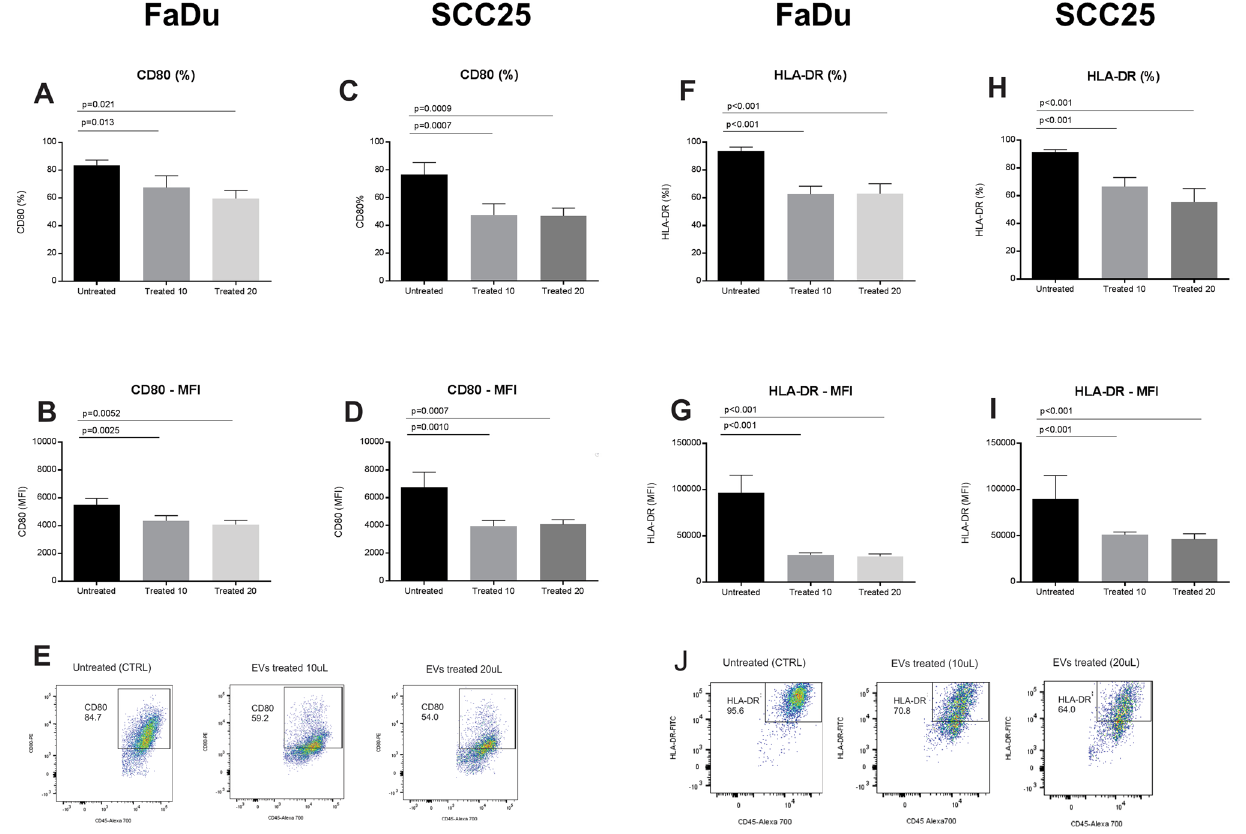
Figure 8. Expression of CD80 and HLA-DR in mDCs both in the presence and absence of EVs derived from the FaDu and SCC25 cell lines. FaDu cell line: ( A ) there was a significant difference in the percentage of mDCs expressing CD80 between the control (83.7 ± 3.7%) and EV-treated cells (67.7 ± 8.4% and 59.6 ± 5.9%); ( B ) there was a significant difference in MFI of CD80 in mDCs between the control (5507 ± 452) and EV-treated cells (4343 ± 374 and 4082 ± 299) depending on EVs concentration. SCC25 cell line: ( C ) there was a significant difference in the percentage of mDCs expressing CD80 between the control (76.5% ± 8.8) and EV-treated cells (47.6 ± 8.0 and 46.8 ± 5.9) at the higher concentration of EVs, ( D) there was a significant difference in CD80 MFI in mDCs between the control (6735 ± 1106) and EV-treated cells (3943 ± 420 and 4078 ± 336); ( E ) Representative dot plots displaying mDCs expressing CD80 on day 7 of culture without treatment (CTRL) and EV-treated cells. FaDu cell line: ( F ) there were significant differences in the percentage of mDCs expressing HLA-DR between the control (93.6 ± 2.8%) and EV-treated cells (62.6 ± 5.7% and 63 ± 7.1%); ( G ) there were significant differences in HLA-DR MFI between the control (96,646 ± 18,762) and treated cells (29,523 ± 18,762 and 27,865 ± 2527). SCC25 cell line: ( H ) there was a significant difference in the percentage of mDCs expressing HLA-DR between the control (99.3 ± 0.5%) and EV-treated cells (96.6 ± 2.8% and 96.8 + 2.3%); ( I ) there were differences between HLA-DR MFI from control (99,974 + 1,301) and EV-treated cells (66,778 ± 2605 and 59,898 ± 7024); ( J ) Representative dot plots displaying mDCs expressing HLA-DR on day 7 of culture without treatment (CTRL) and EV-treated cells. Representative results of n = 4 samples per lineage type. The statistical analysis was performed using one way ANOVA with Dunnett anti-mouse antibody coupled with Alexa-568 (1:100, Invitrogen) in blocking solution for 1 h. After final wash in blocking solution, cells were rinsed three times with PBS and mounted in 1:10 PBS diluted Fluoromount-G with DAPI (eBiosciences, San Diego, California, USA). Cells were analyzed by confocal microscopy (Zeiss 710 Confocal Microscope, Zeiss, Germany) with specific staining for CD209 (red), EVs (green), and nuclei (blue), dysplayed individually and overlapped. In addition, the Z-stack tool was used for sequential photos with diferent deepness, and a 3D photo was captured in order to show the localization of EVs inside the mDC. Cell viability analysis of mono-DCs treated with EVs.